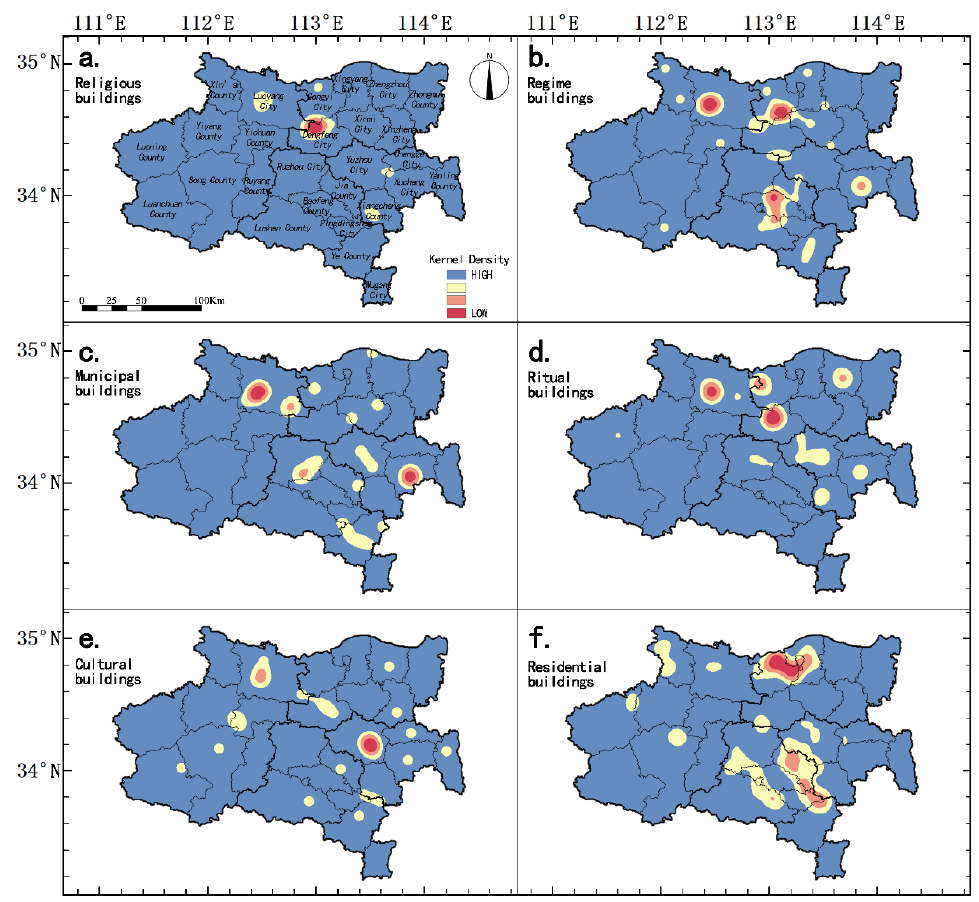
Figure 8. Kernel density of different types of historical buildings’ distribution in the Songshan region.